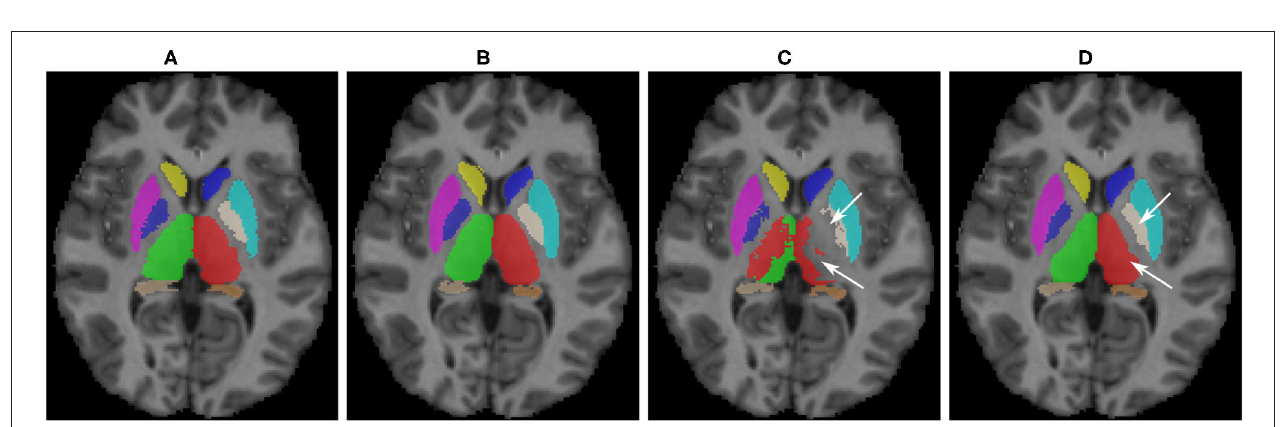
FIGURE 5 | Qualitative results for sub-cortical structure segmentation: (A) Ground truth; (B) FIRST segmentation; (C) Pre-trained baseline CNN output without domain adaptation; (D) After domain adaptation. Arrows indicate: top → pallidum; bottom → thalamus.